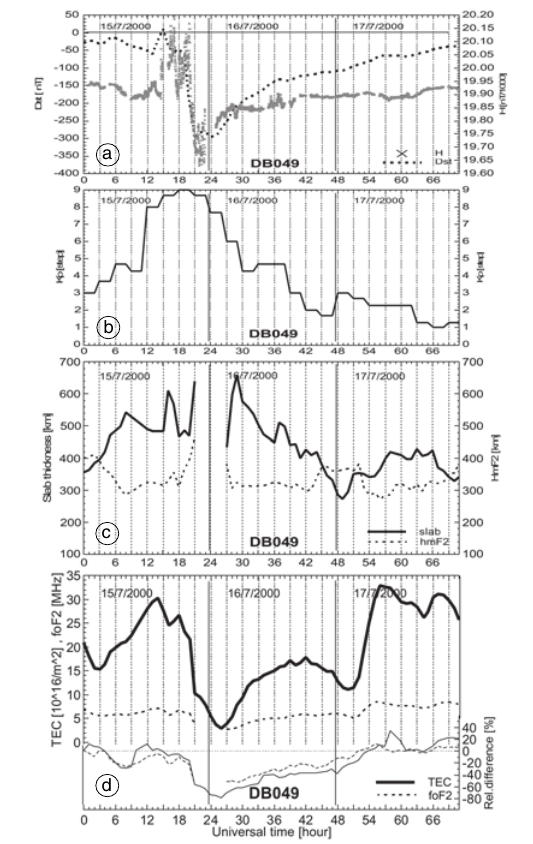
Fig. 3a-d. Ionosphere-plasmasphere response to the 15th-17th July 2000 geomagnetic storm as observed at the site of the Dourbes ionosonde station DB049 (4.6 ° E, 50.1 °